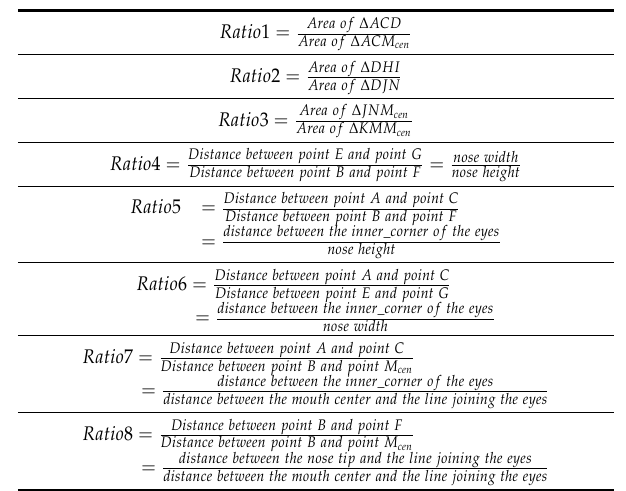
Table A1. Facial feature